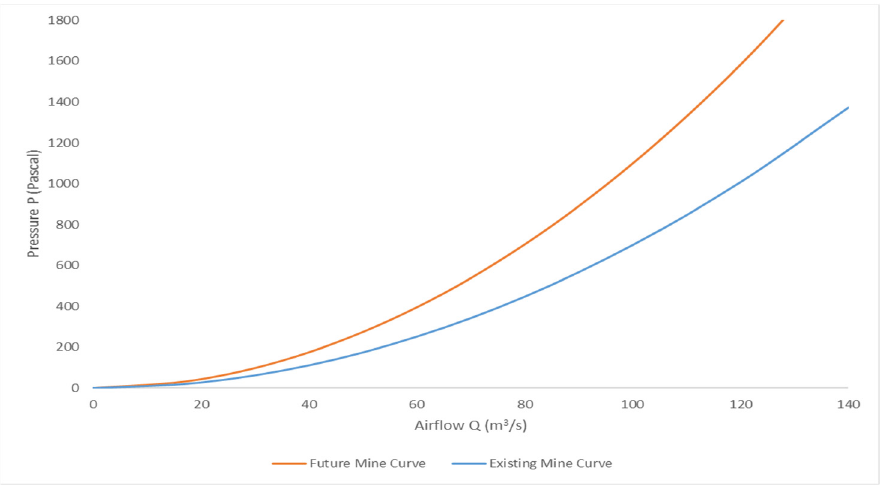
Figure 4. Existing and future mine curves.